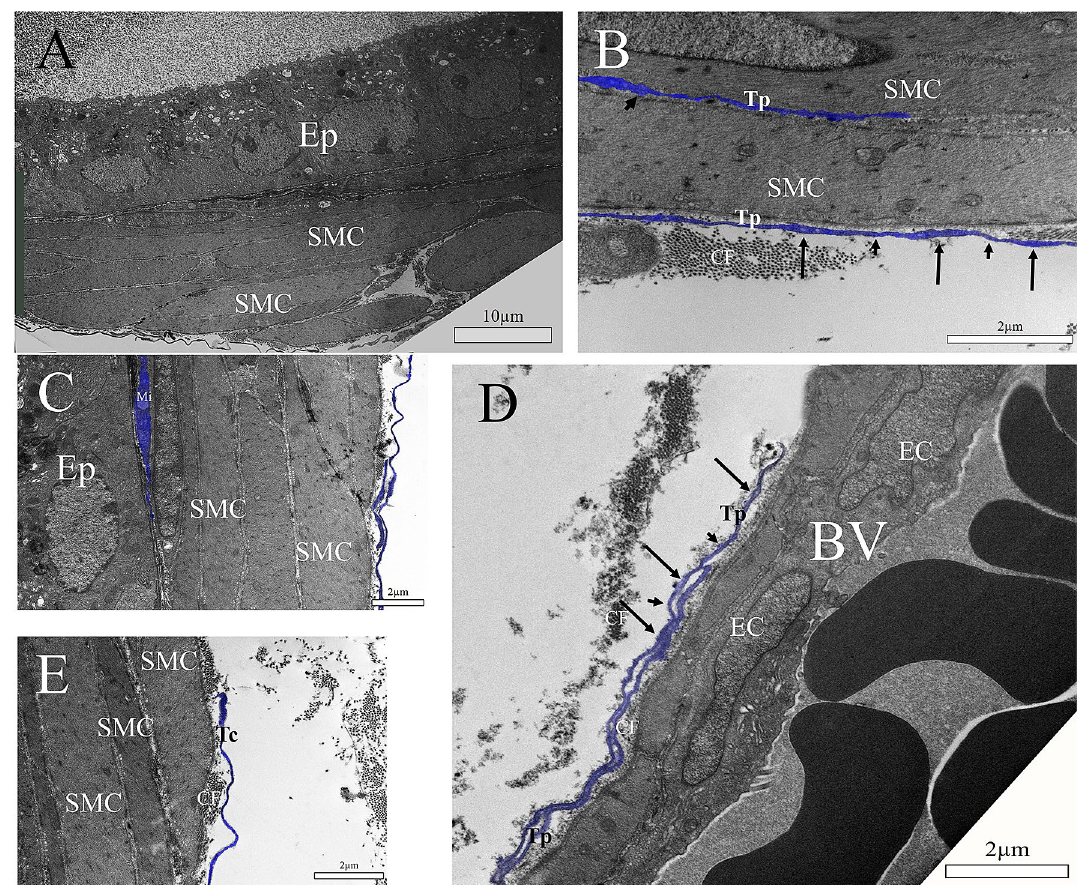
Figure 2. Ultrastructure of the ventral prostate of adult male gerbils (3 months old). ( A ) A stratified perialveolar smooth muscle layer can be seen; the epithelium is polarized, with vesicles going towards the apical region of the secretory cells, which is in contact with the alveolar lumen. ( B ) A telocyte can be observed in the interstitial region with close association to collagen fibrils; it is possible to observe its telopode divided into podomers and podoms. Another telopode is observed between two smooth muscle cells. ( C ) A subepithelial telocyte can be observed, which is closely associated to both epithelial and smooth muscle layers.